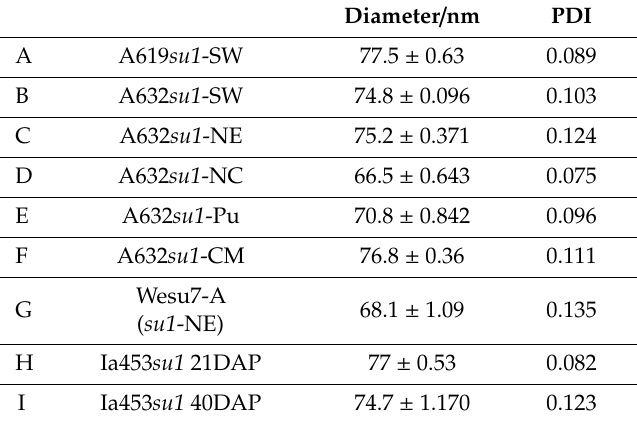
Table 2. Hydrodynamic diameter and polydispersity of phytoglycogen extracts isolated using ethanol precipitation.